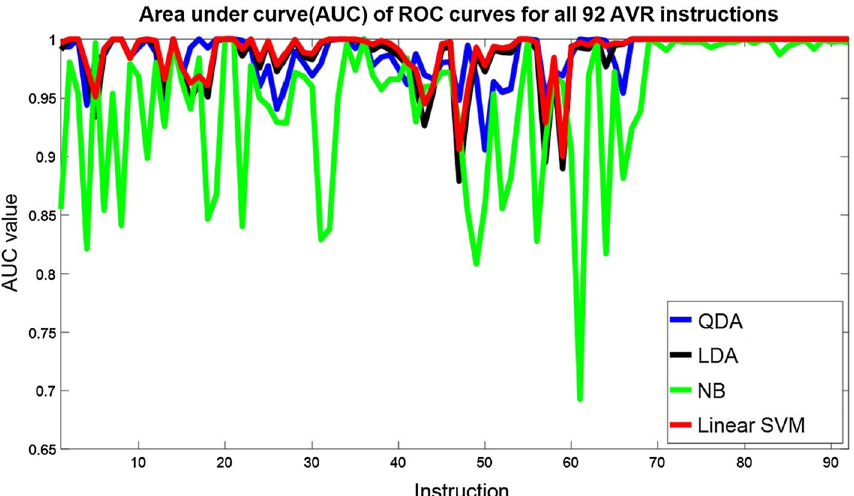
Fig. 8 Area under curve (AUC) value of ROC curves for all 92 AVR